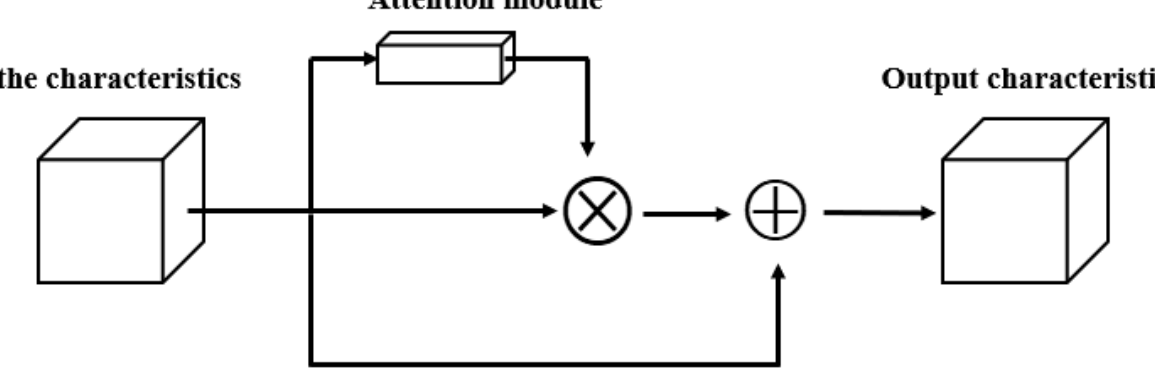
Figure 3. Feature weighted fusion method based on the attention mechanism.